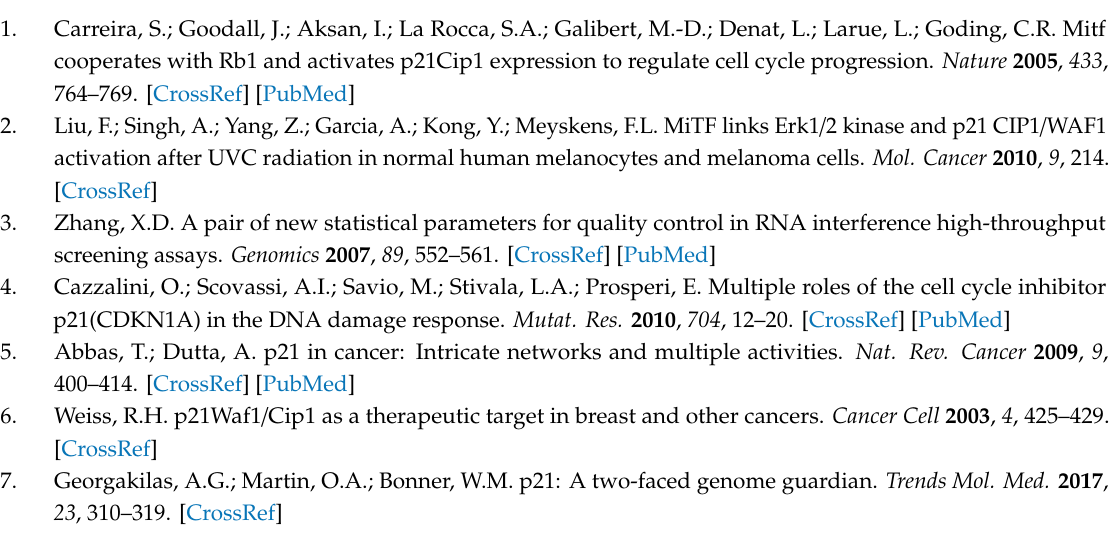
Figure S1: (A) Western blot analysis of pWee (Ser642), Myt1, Cyclin B1, AuroraB, p27, pHH3 (Ser10), Cyclin E2, pCdc2 (Tyr15), Cyclin A2, and p18 protein levels in HeLa WT cells compared with HeLa TFEB KO. β -actin protein levels were used as a loading control. (B) Quantification of p21 mRNA in HeLa WT compared with TFEB KO cells. (C) Quantification of p21 and TFEB mRNA in HeLa TFEB KO cells after the transfection with either an empty vector (3xflagCMV14) or a plasmid encoding constitutive nuclear-localized-TFEB (TFEB S211Ax3flag). Data are represented as mean ± SEM of three independent experiments. ** p < 0.01, *** p < 0.001 (two-tailed Student’s t-test). (D) Schematic representation of the region of p21 promoter used in this study. Figure S2: (A,B) Western blot analysis and quantification of p21 and p53 in HeLa WT after the transfection with either an empty vector (3xflagCMV14) or a plasmid encoding constitutive nuclear-localized-TFEB (TFEB S211Ax3flag). β -actin protein levels were used as a loading control. (C) p21 mRNA levels in HeLa WT after the transfection with either an empty vector (3xflagCMV14) or a plasmid encoding constitutive nuclear-localized-TFEB (TFEB S211Ax3flag). (D) Quantification of p21 and TFEB mRNA in SAOS-2 p53 null cells after transfection with an empty vector (3xflagCMV14), a plasmid encoding TFEB S211Ax3flag, a p53-encoding plasmid, or the combination of both p53- and TFEB S211A-encoding plasmids. (E) Quantification of p21 and TFEB mRNA in HeLa WT compared with TFEB KO cells after transfection with either an empty vector (3xflagCMV14) or a plasmid encoding p53. Data are represented as mean ± SEM of three independent experiments. ** p < 0.01, *** p < 0.001 vs. DMSO (two-tailed Student’s t-test). Figure S3: (A) p21 mRNA levels in HeLa WT cells stably expressing TFEB 3xflag upon treatment with either DMSO or doxorubicin (DOX) at 0.5 µ M for 4 h. (B) Western blot analysis of p21 in SAOS-2 p53 null cells upon treatment with either DMSO or doxorubicin (DOX) at 0.5 µ M for 4 h, HeLa WT were used as doxorubicin control. Data are represented as mean ± SEM of three independent experiments. *** p < 0.001 (two-tailed Student’s t-test). Figure S4: Representative histograms showing flow cytometry analysis of cell cycle in HeLa WT compared with HeLa TFEB KO after the treatment with doxorubicin (10 nM and 50 nM) for 48